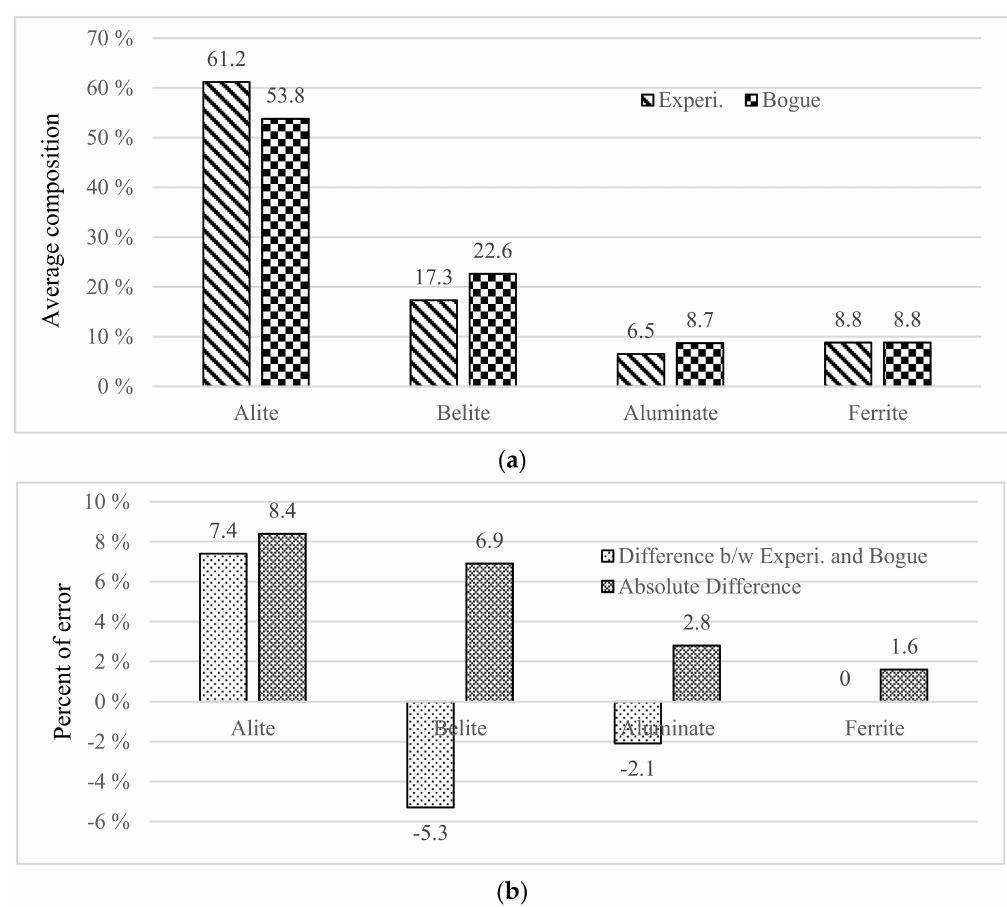
Figure 2. Comparison of experimental and calculated (by the Bogue models) cement compound contents: ( a ) the average values of experimental and calculated cement compound contents; ( b ) the average differences and the average absolute differences between the two, where the differences are percentages of error from experiment and Bogue model.